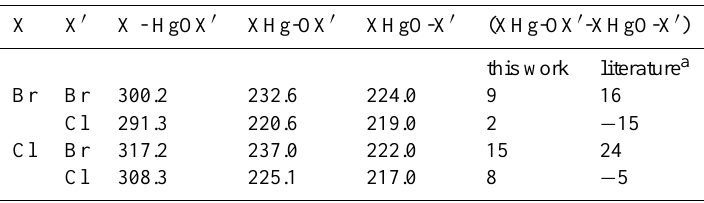
Table 2. XHgOX 0 bond energies (kJmol − 1 ) at a temperature of 0K using CCSD(T)/aVTZ single point energies computed with B3LYP/aVTZ structures and zero-point energy